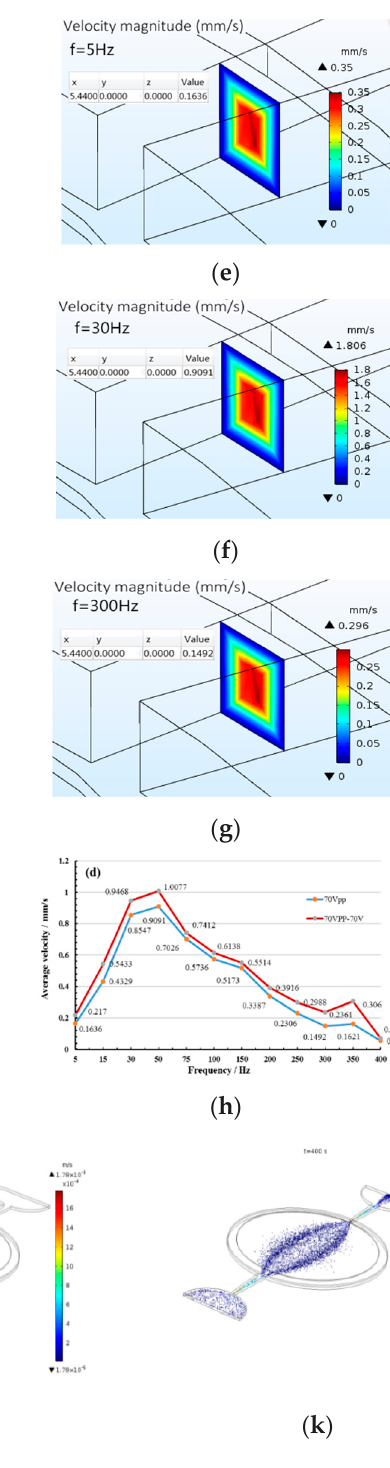
Figure 5. The FEA model and numerical analysis results of the whole micropump. ( a ) FEA model of the micropump with combined LC/PZT driving. ( b – d ) The velocity contours of pump chamber and the microchannel under single PZT driving, single LC driving and combined driving. ( e – g ) The velocity contours of the A–A cross-section under 5 Hz, 30 Hz, and 300 Hz driving frequencies. ( h ) The average velocity curve vs. frequency. ( i – k ) The flow trajectory of liquid crystal particles with the DC power supply at 15 s, 150 s, and 400 s.